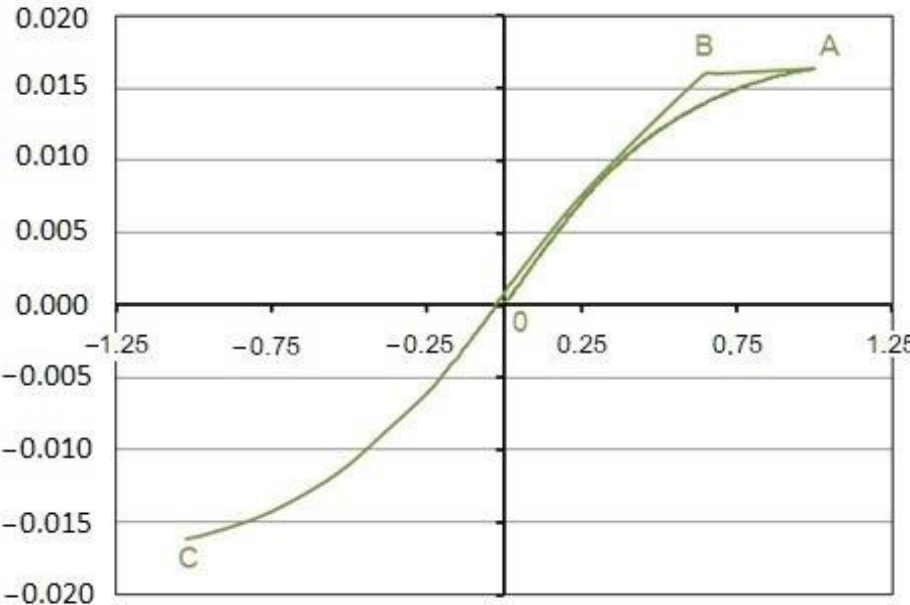
Figure 16. The kinematic error of circular spline in reversing motion relative to the angle of rotation of a double-disc generator.